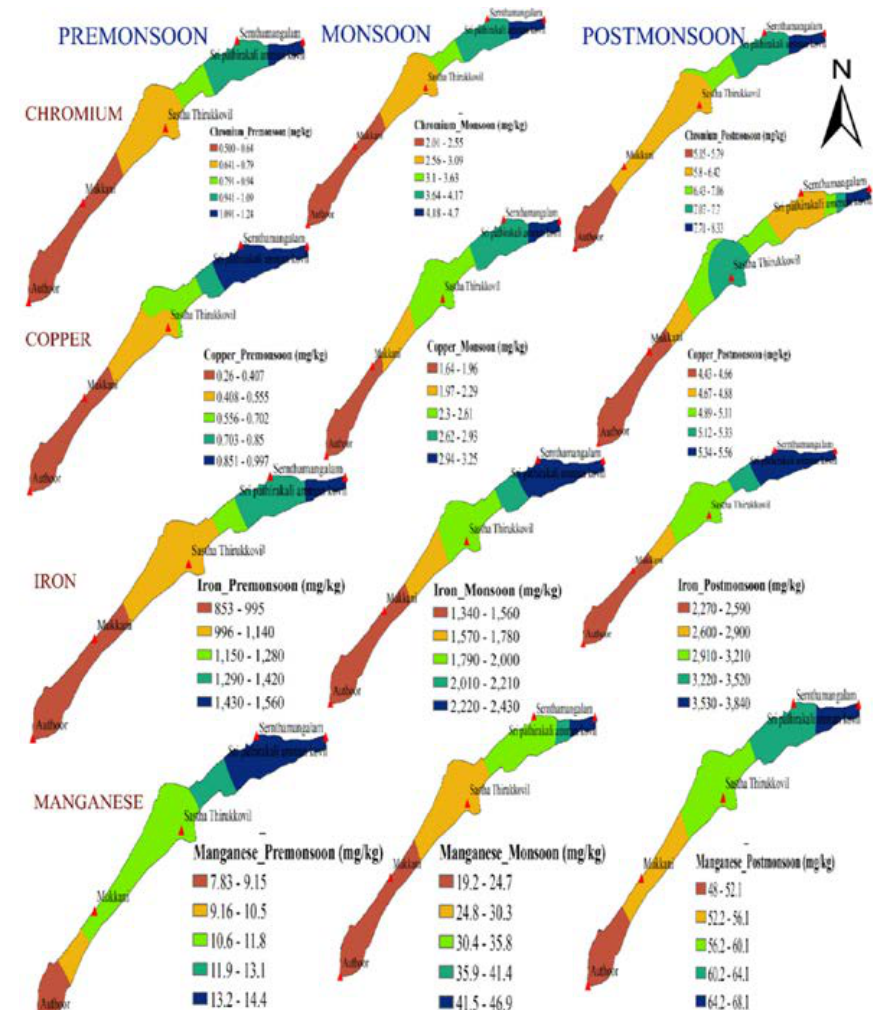
Fig. 3: Seasonal variations of heavy metals in